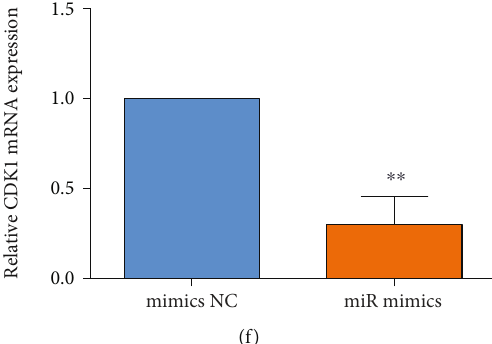
Figure 10: miR-193b-3p negatively modulated CDK1. (a) miRNA enrichment analysis of DEGs. (b) The predicted binding location between miR-193b-3p and CDK1 3 ′ UTR. (c) – (e) The HEK293T cells were transfected with mimics NC or miR-193b-3p mimics, and relative expression of miR-193b-3p in HEK293T cells was measured by qRT-PCR; (d) relative luciferase activity of wild-type (WT) CDK1 3 ′ UTR reporter vector in HEK293T cells was evaluated by Dual-Luciferase reporter assay kit; (e) the relative luciferase activity of mutant (MUT) CDK1 3 ′ UTR reporter vector in HEK293T cells was determined by the Dual-Luciferase reporter assay kit; and (f) mRNA expression level of CDK1 in the SMMC7721 cells. N = 3 ; ** P < 0 : 01 and *** P < 0 : 001